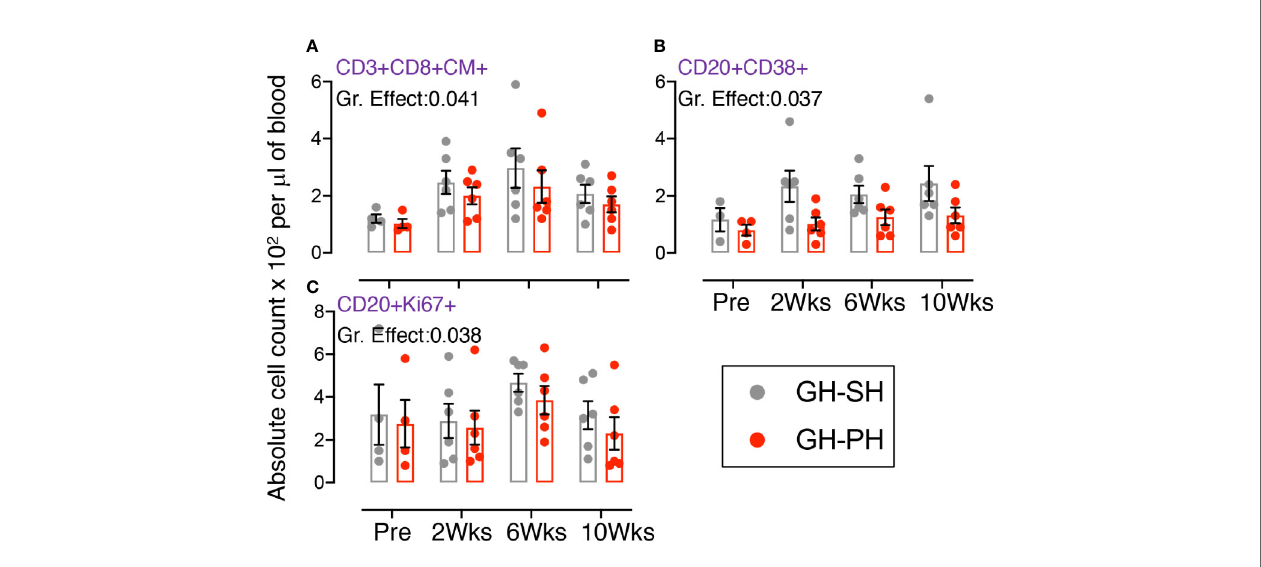
FIGURE 2 | Absolute count of peripheral blood central memory (CM) CD3+CD8+CD28+CD95+, activating CD20+CD38+, and proliferating CD20+Ki67+ lymphocyte were shown for GH-SH and GH-PH groups. A signi fi cant difference in absolute CD8+CM+ (A) and CD20+CD38+ (B) , and CD20+Ki67+ (C) cells was detected between these groups across house treatment time points. The X axis denotes pre- and post-separation housing time points and the Y axis denotes absolute counts. Individual values from each animal are shown as colored circles with bars showing mean ± standard error for each